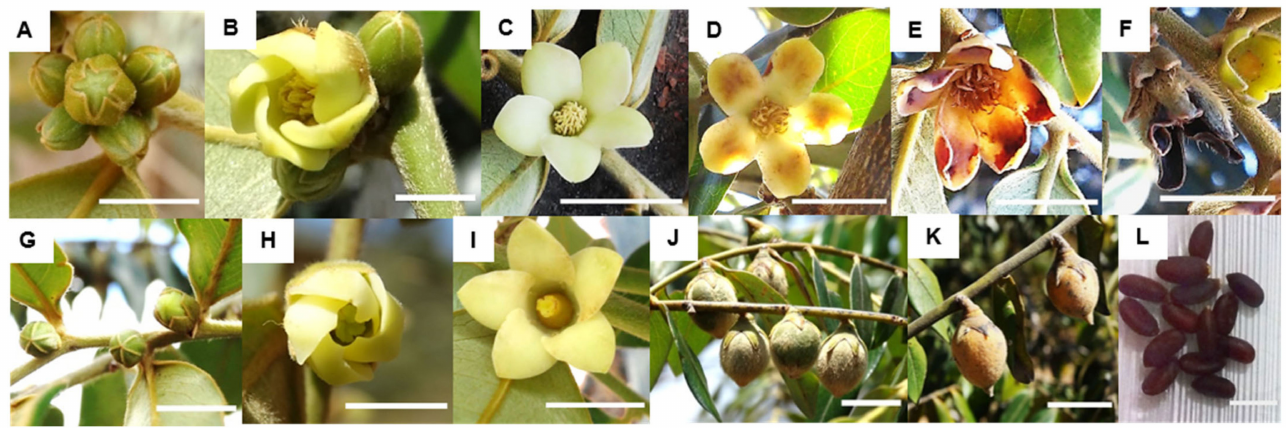
Figure 4. Floral development of D. sericea observed in the surroundings of the PESNT. Structurally male individuals: ( A ) flower buds; ( B ) flower in anthesis; ( C ) blooming flower; ( D ) flower at the onset of senescence with brownish anthers and petal lobes; ( E ) oxidation of the floral features (corolla and stamens); ( F ) completely oxidated flower. Structurally female individuals: ( G ) buds; ( H ) flower in anthesis; ( I ) blooming flower; ( J ) immature fruits; ( K ) mature fruits; ( L ) seeds. ( A – G , I ) scale bar = 1 cm; ( H ) bar = 0.5 cm; ( J – L ) bar = 3